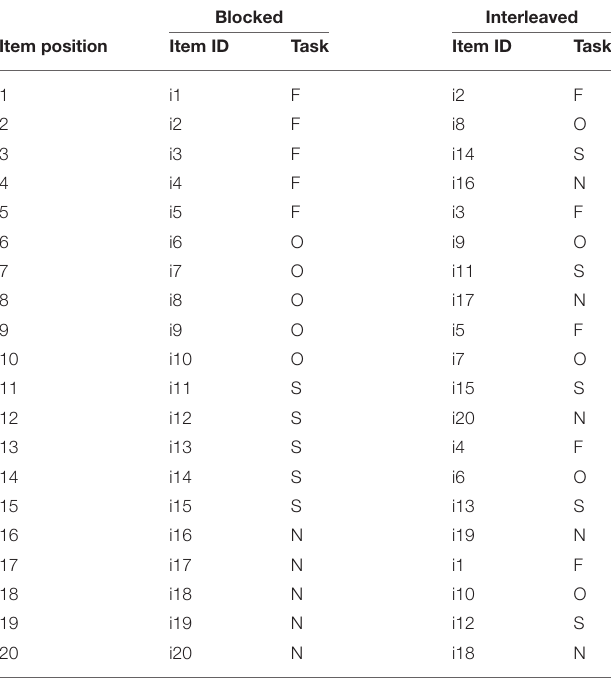
TABLE 2 | Form design with item and task by item